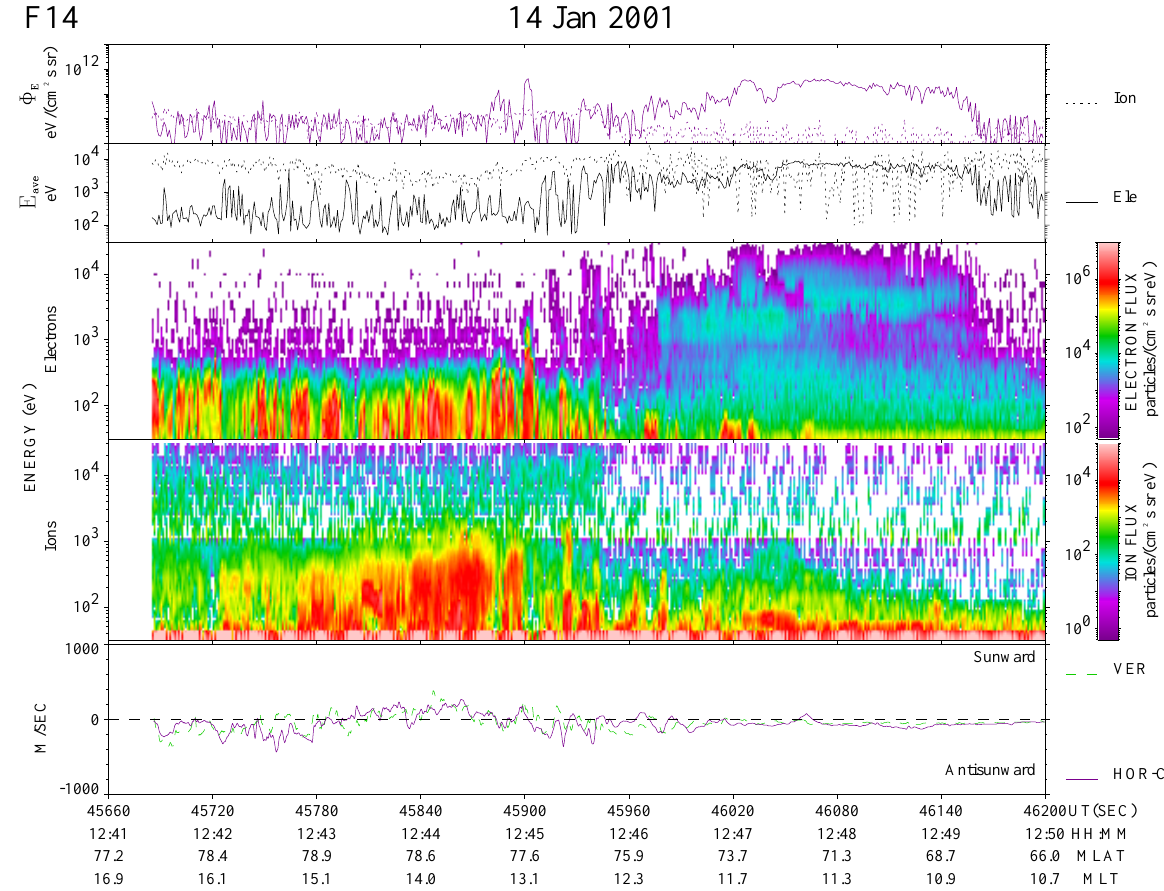
Fig. 6. DMSP-F14 observations of particle precipitation and plasma flow along the path indicated by the straight red line in the top left frame of Fig. 5. The upper two panels display energy flux and average energy for the ion and electron precipitation. The third and the fourth panels show electron and ion fluxes versus energy and time. The bottom panel displays the cross-track plasma flow versus time. The green curve represents the vertical component (positive upward) and the magenta curve represents the horizontal component (positive sunward).